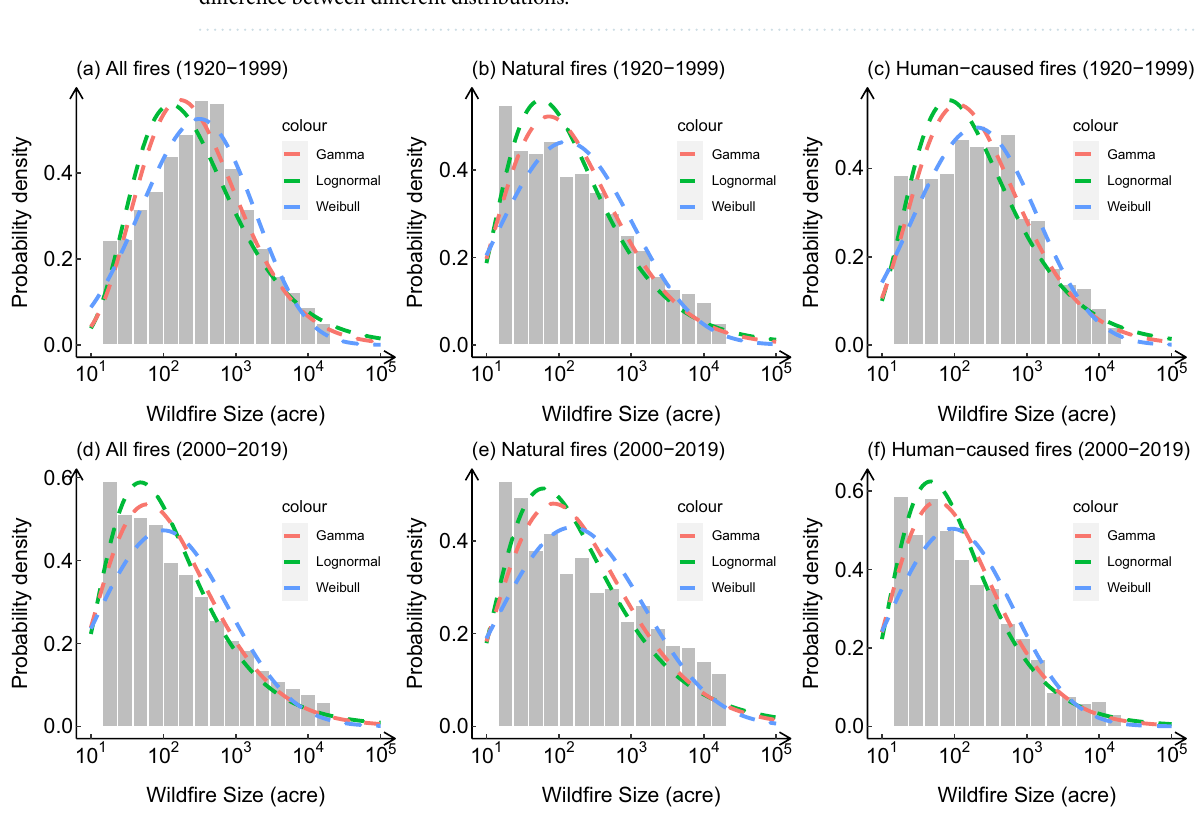
Figure 1. The empirical histogram of wildfire size and the typical heavy tailed distribution fitting curves for wildfires in ( a ) 1920–1999 and ( b ) 2000–2019. The wildfire sizes are in acres (1000 acre = 4.05 km curve with different colors represent different types of distribution, the black, yellow, red, green, and blue curves represent the fitting result of Gamma, Log-normal, Pareto, Truncated Pareto, and Weibull distribution, separately. The tail of the distribution was truncated from the burned area of 2000 acres to show the fitting difference between different distributions.